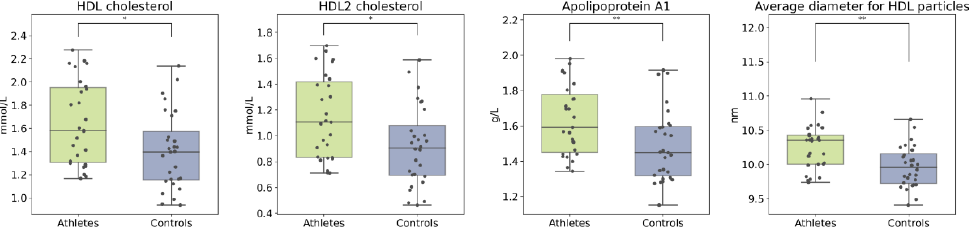
Figure 5. Boxplots of HDL cholesterol and related metabolites. Kruskal–Wallis p value: * < 0.05, ** < 0.01.